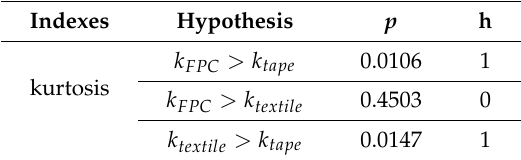
Table 9. Significant t -test of signal quality indexes of three materials (alpha = 0.05).